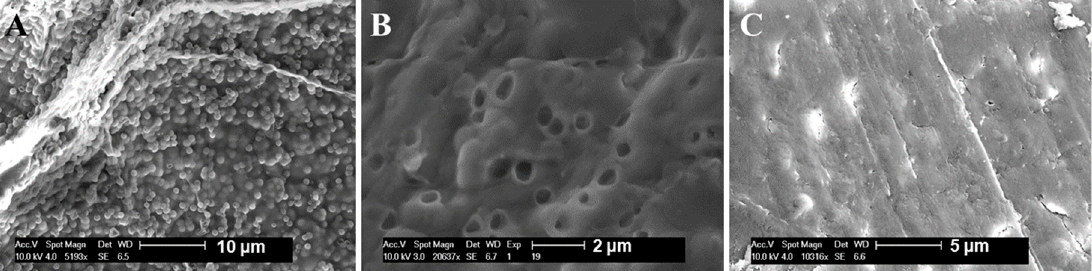
Figure 3. SEM photos of ( A , B ) mp-CA/GO/CA and ( C ) CA.